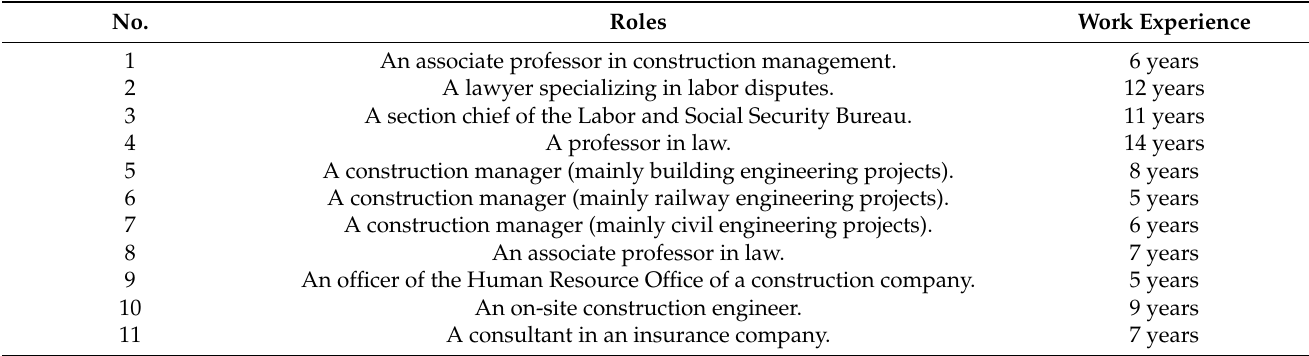
Table 1 lists the details of the interviewees. Table 1. Profiles of